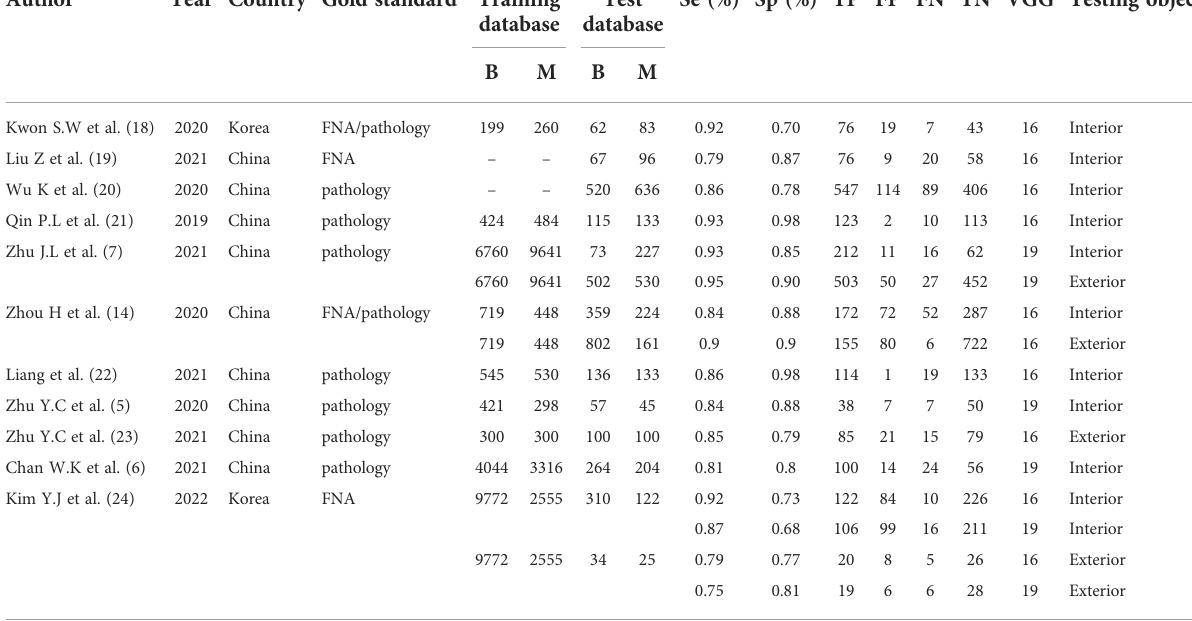
TABLE 1 Characteristics of the included